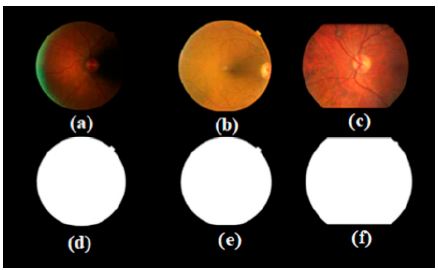
Figure 3. Original retinal image ( a – c ) and corresponding segmented FOV ( d – f ).